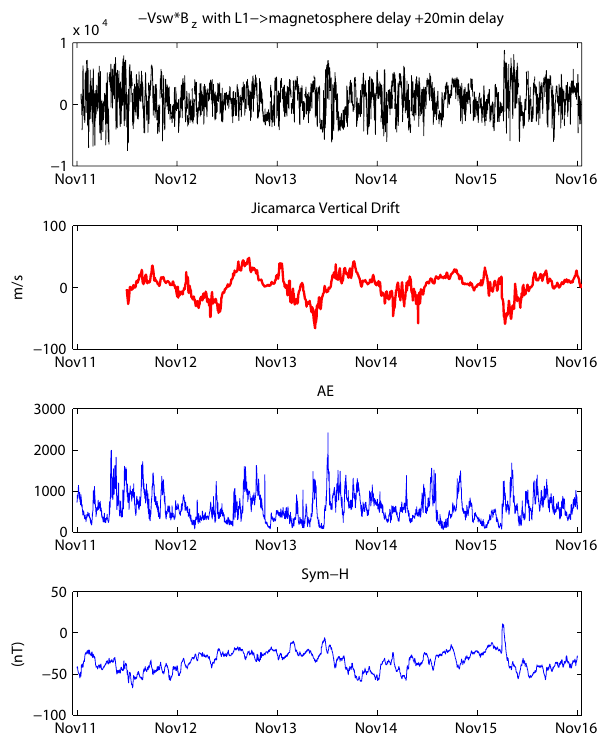
Fig. 2. Coincident measurements by Ace ( − V sw × B z ) , Jicamarca vertical drift, AE, and